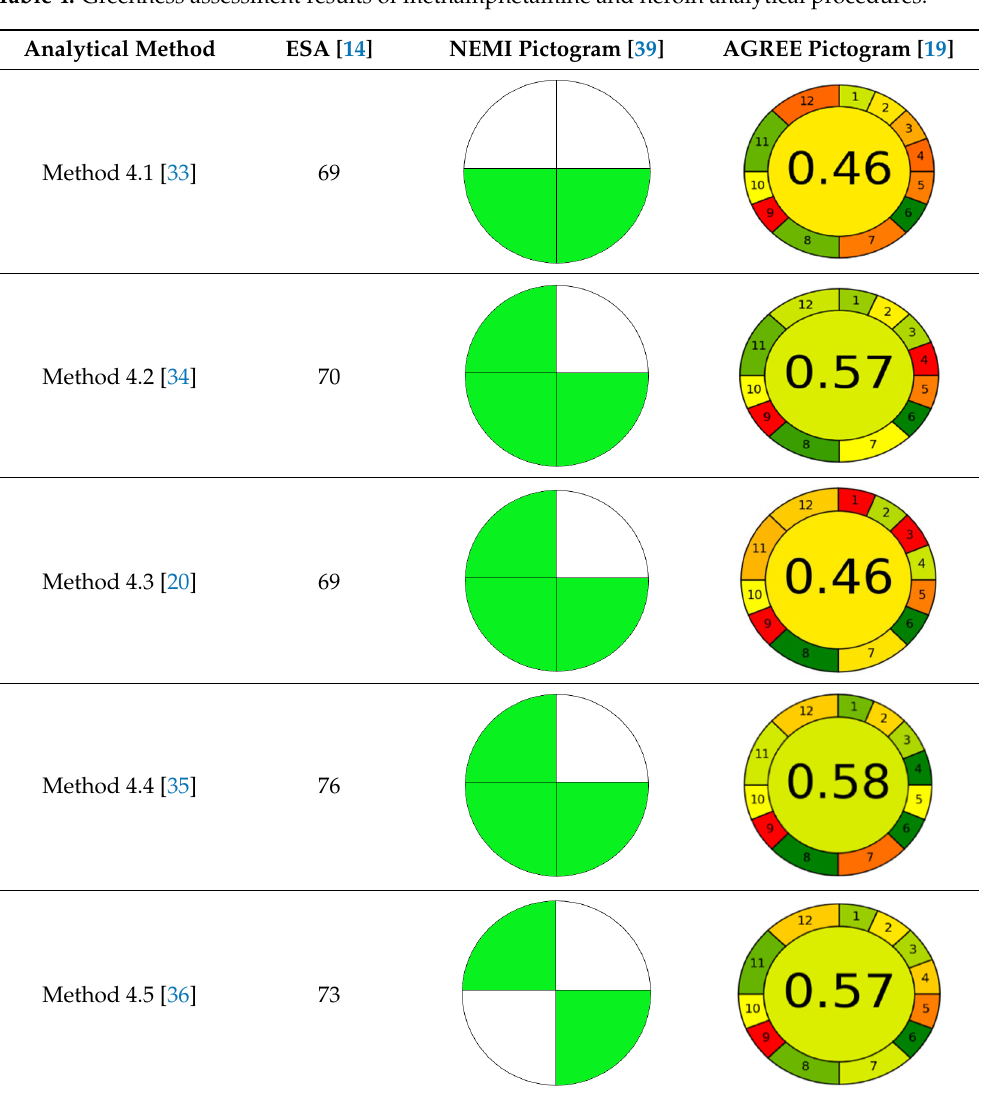
Table 4. Greenness assessment results of methamphetamine and heroin analytical procedures.